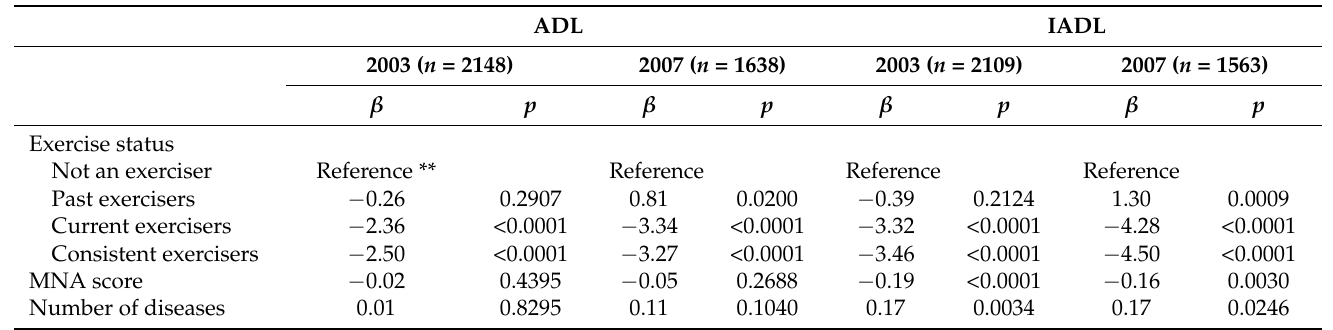
Table 3. The regression analysis of the associations of change of exercise status over 4- and 8 years, MNA score and number of diseases with ADL and IADL scores in 2003 and 2007 *.